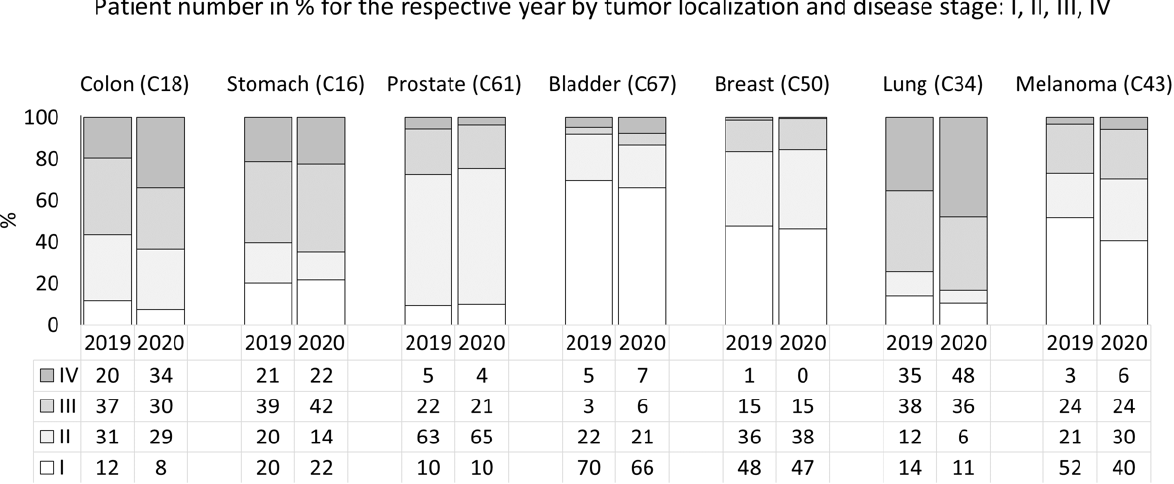
Figure 3. Percentage of surgically treated newly diagnosed cancer patients according to disease stage.